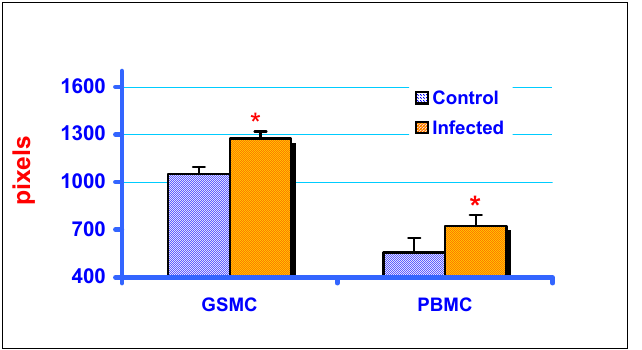
Figure 3. Area profiles of MIP-1 α RT-PCR bands of control, uninfected and CAEV-infected ( in vitro ) GSM cells, and PBM cells in non-infected and CAEV-infected goats. Areas were delineated using the ‘free hand lasso’ PhotoShop 6.0 TM , and were computed using histogram measurements. Significant differences were observed between control and CAEV-infected RT-PCR bands of both GSM cells (P ≤ 0.0035) and PBM cells (P ≤ 0.036). Area measurements were expressed as pixels. *indicates significant difference from